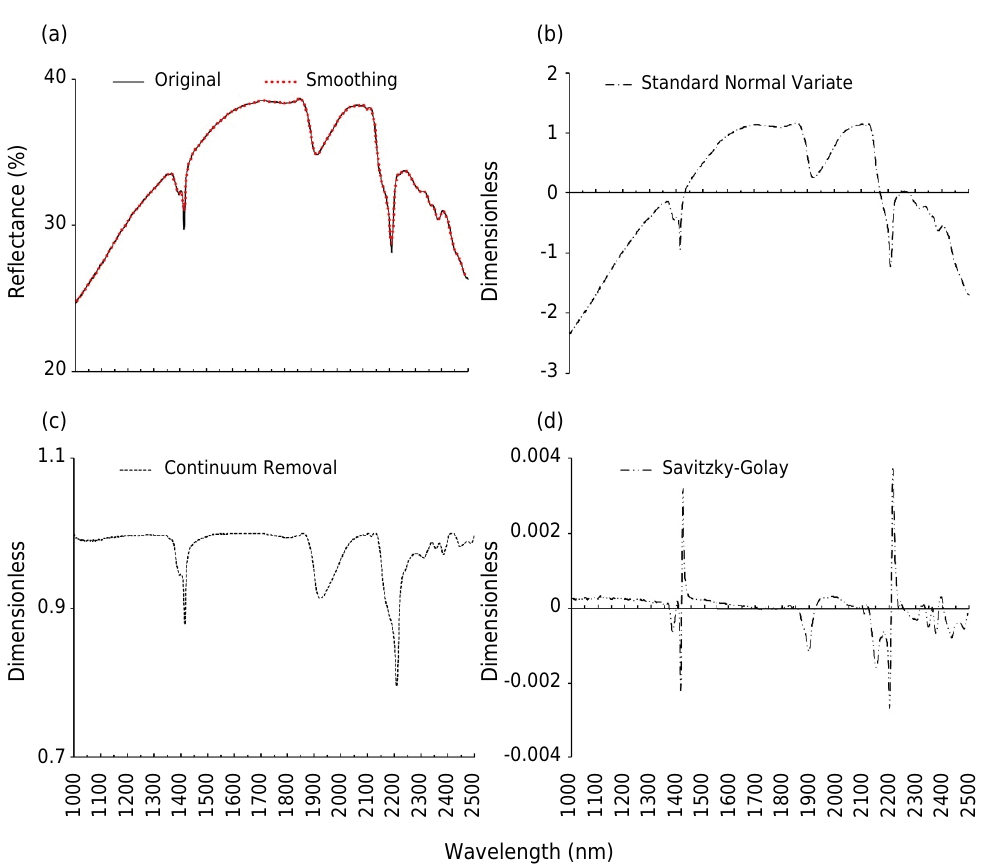
Figure 2. Median of spectral curves preprocessed using smoothing (a), standard normal variate (b), continuum removal (c), and Savitzky-Golay derivative (d)